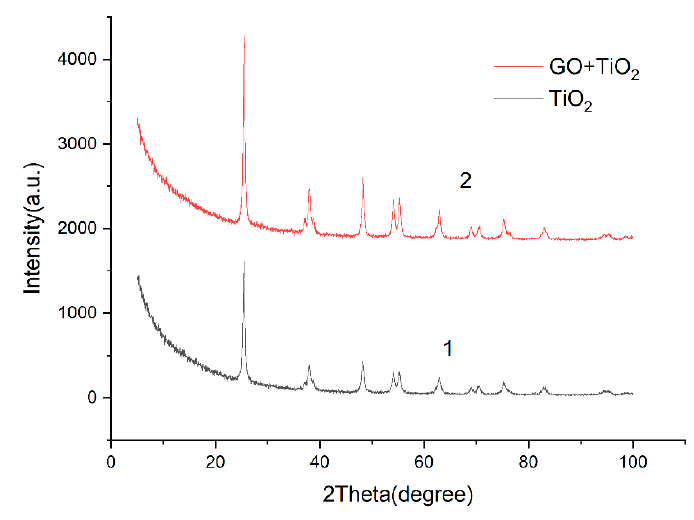
Figure 2. X ray diffraction (XRD) patterns of TiO 2 ( 1 ) and TiO 2 -GO ( 2 ).